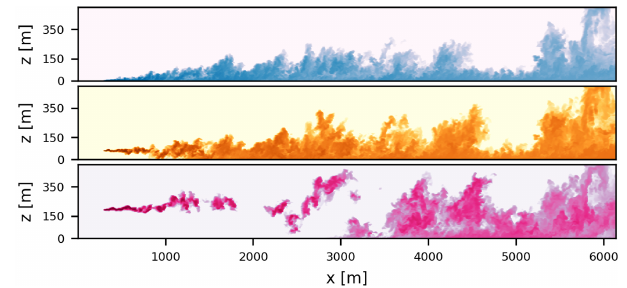
Figure 4. Snapshot of x – z transects of the three plumes taken through the plume centerline. Blue, orange, and pink correspond to emission heights of 0, 60, and 190m, respectively.